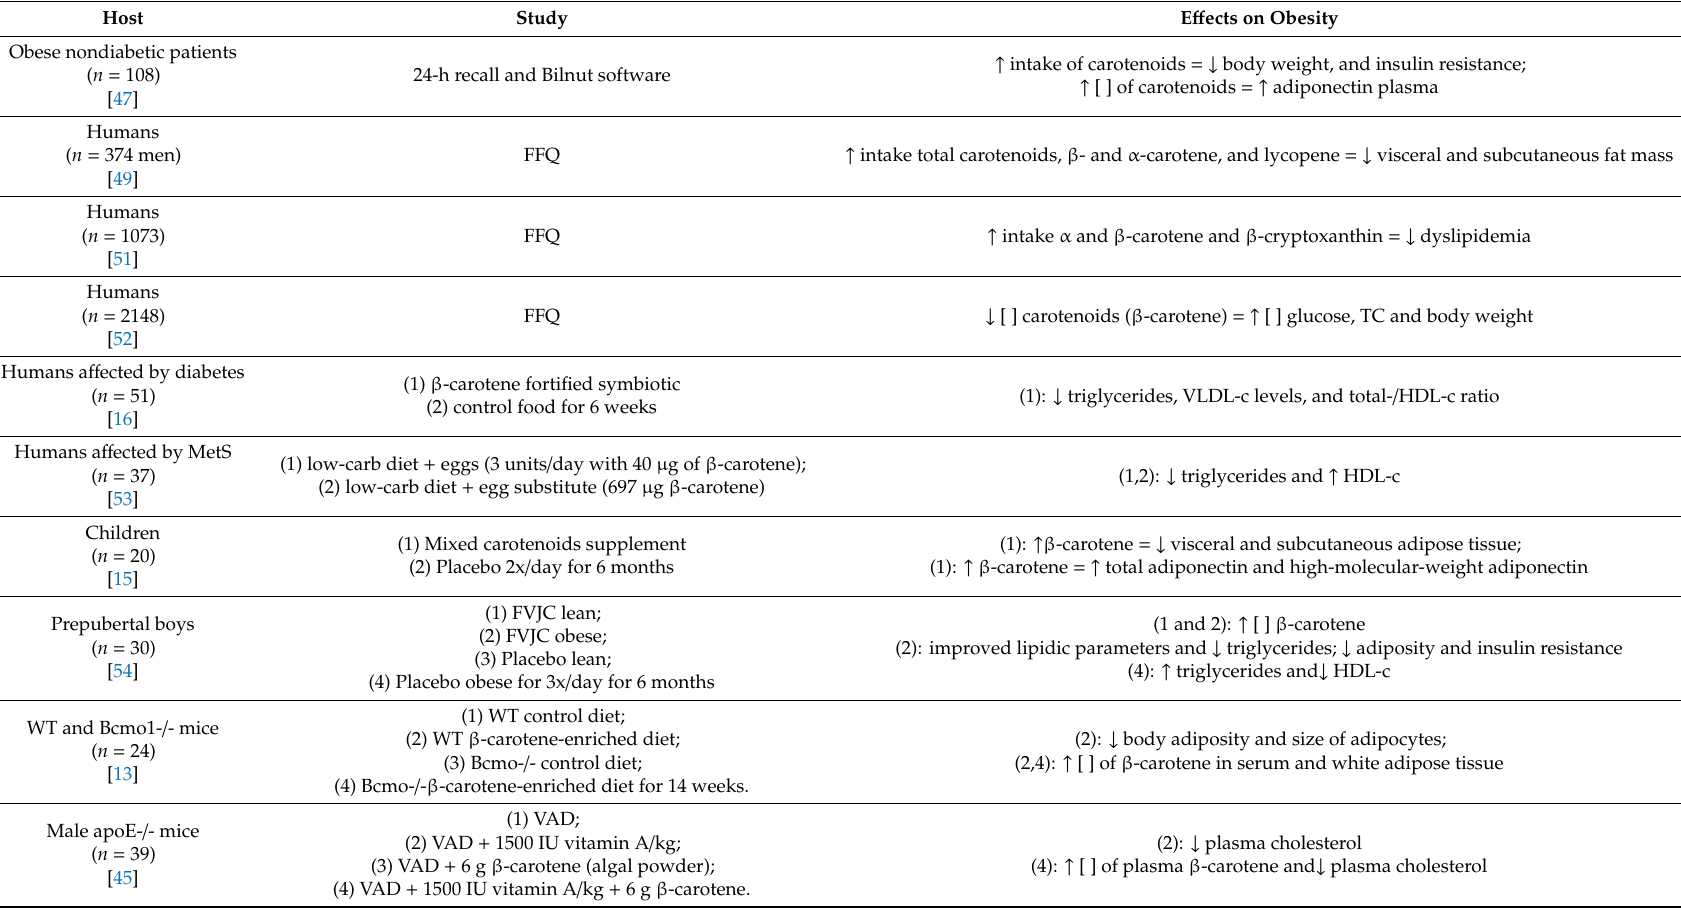
Table 1. E ff ects of carotenoids on